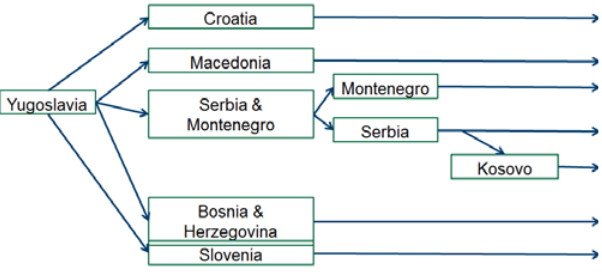
Figure 3. Graph of existential transformations over time.